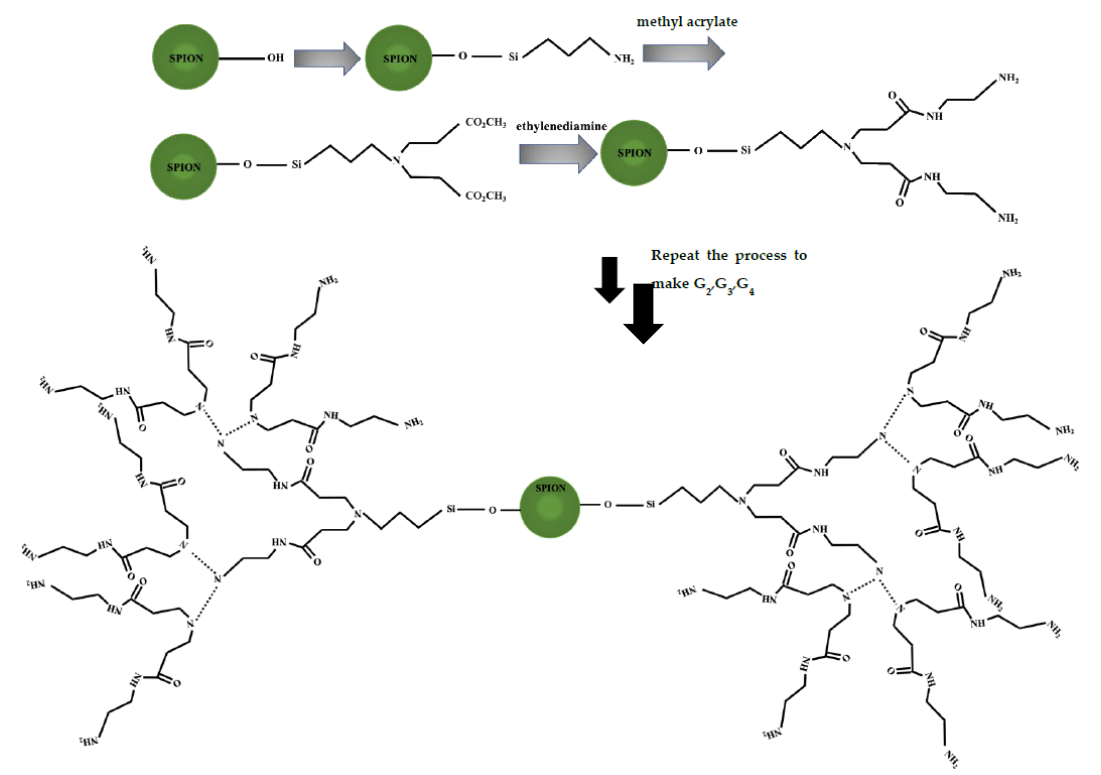
Figure 1. Process of fourth-generation dendrimer functionalization of the SPION surfaces.